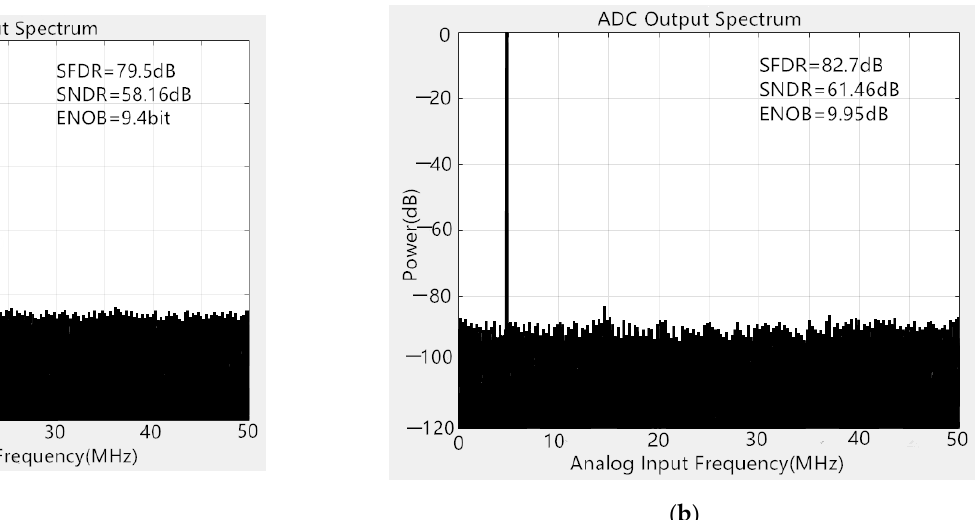
Figure 21. Measured Spectrum at Fin = 4.89 MHz when ( a ) calibration was off and ( b ) calibration was on .